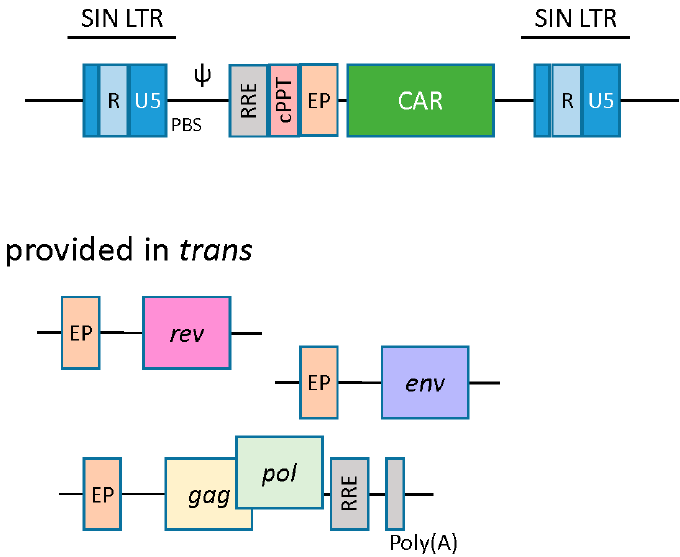
Figure 3. Lentiviral vectors. Lentivirus based vectors are similar to their retroviral counterparts. A split packaging system is utilized with a packaging cell line to produce viral particles. An accessory plasmid provided in trans unique to lentivirus is rev , which enhances nuclear export of gag-pol transcripts. Another component unique to lentiviral vectors is the central polypurine tract (cPPT), which facilitates nuclear import of the preintegration complex. EP, eukaryotic promoter; RRE, rev response element; cPPT, central polypurine tract; PBS, tRNA primer-binding site; Ψ , encapsidation signal.